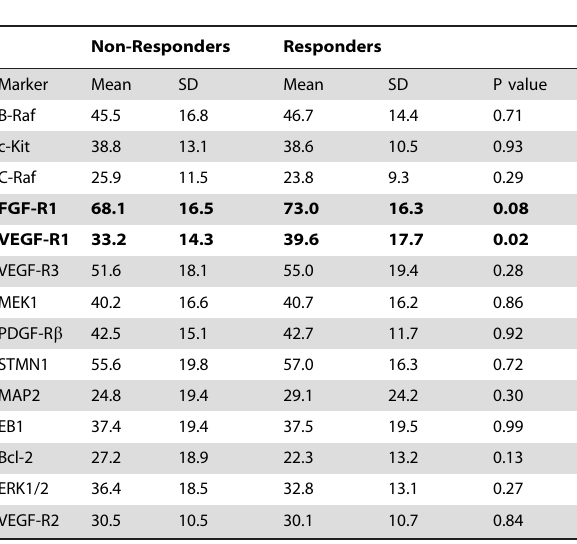
Table 1. Average level of expression for each biomarker (continuous AQUA scores) by response